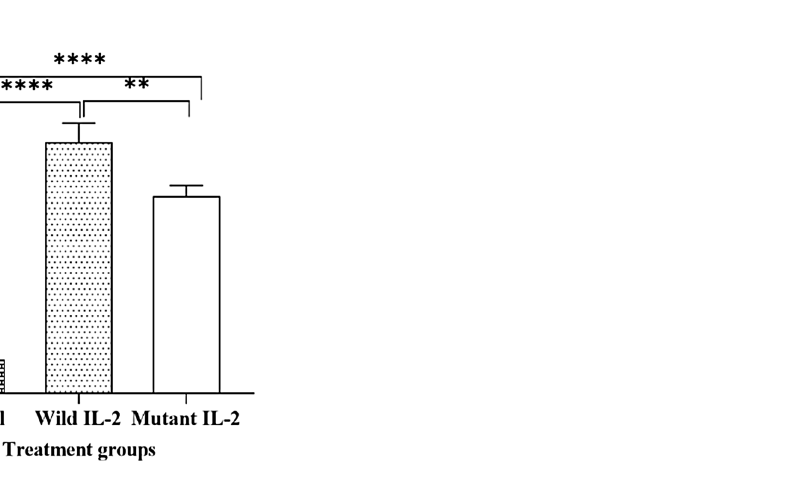
Figure 3. Assessment of IFN-γ secretion in IL-2 treated PBMCs. The results are mean ± SD values of triplicate experiments. Data comparisons were analyzed using ANOVA test (** P < 0.05; **** P < 0.0001).